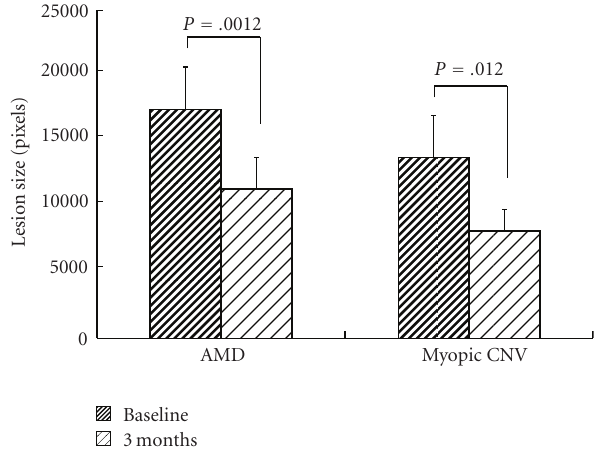
Figure 2: Change in lesion size with oral bisphosphonates. The values are presented as means + SEM.